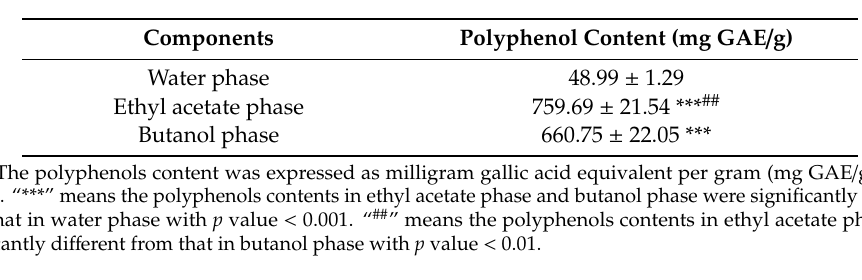
Table 1. The polyphenols content of three